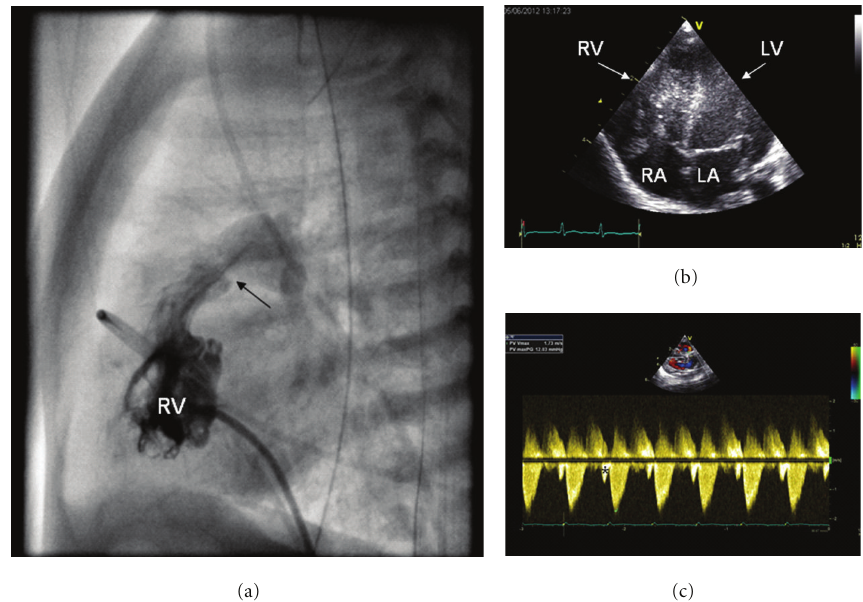
Figure 2: (a) Depicts the stenosis of the pulmonary valve during contrast injection into the right ventricle (RV) obtained during cardiac catheterization. Note the very small opening of the pulmonary valve (arrow). (b) Shows an apical 4-chamber view obtained with echocardiography. Note the echogenic hypertrophied trabeculae within the cavum of the RV. (c) Shows the continuous wave Doppler tracing along the main pulmonary artery with a peak gradient of 12mmHg. Furthermore, the end diastolic forward flow over the pulmonary valve is clearly depicted ( ∗ ) as a sign of restrictive RV filling. LA: left atrium, LV: left ventricle, RA: right atrium, RV: right ventricle.